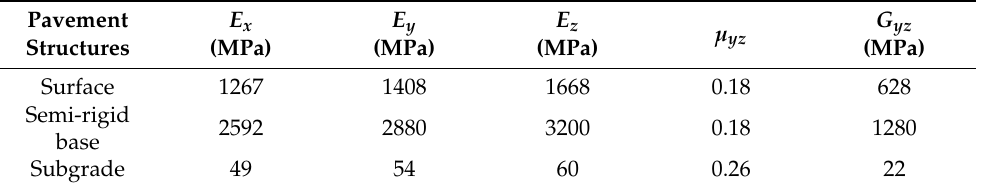
Table 1. The five independent parameters of orthotropic materials.